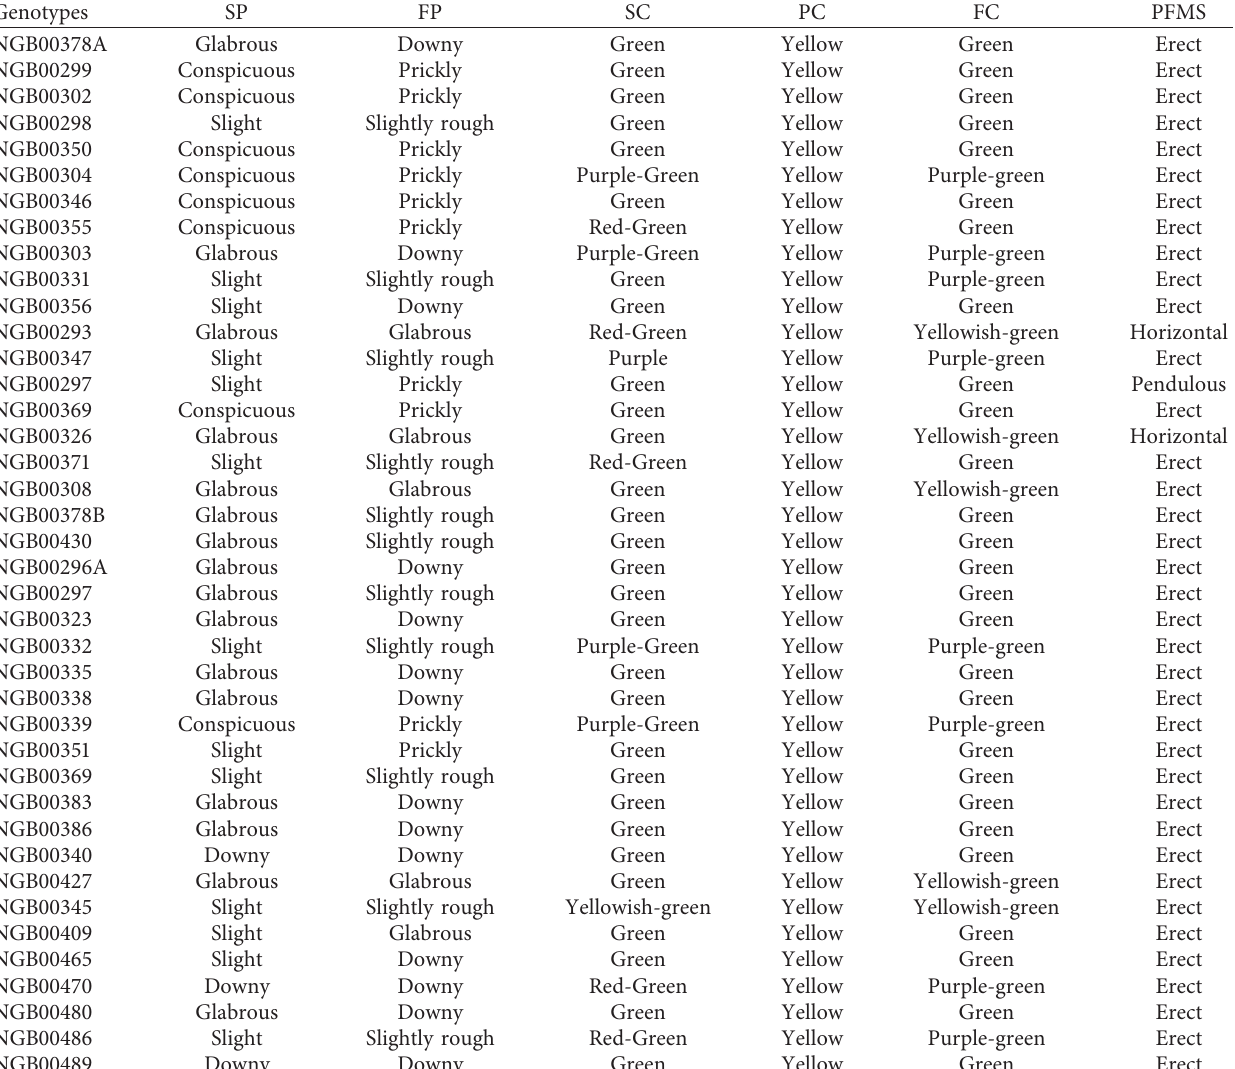
Table 1: Variation in qualitative traits of forty genotypes of